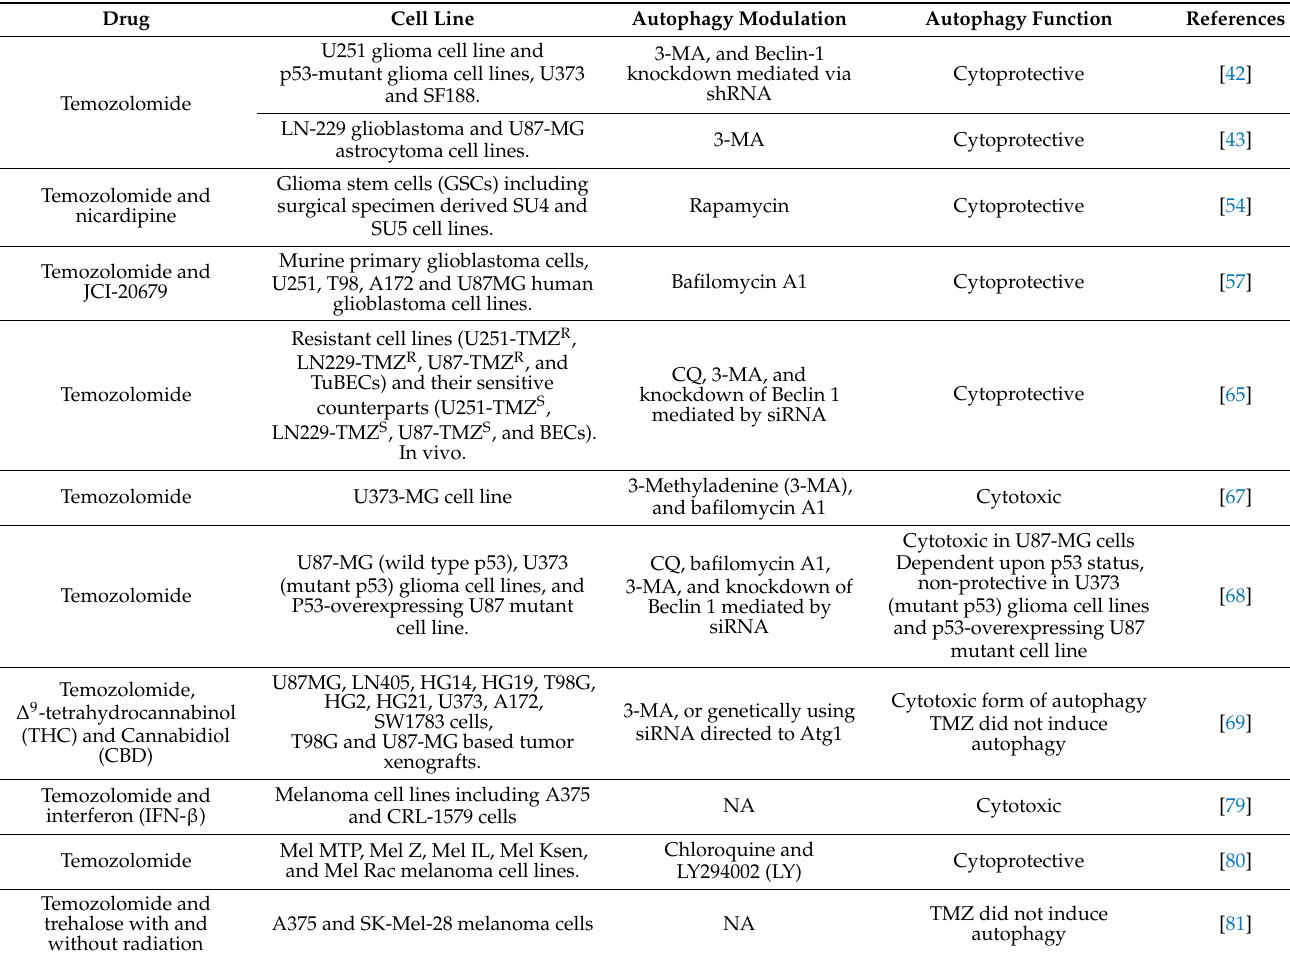
Table 2. The roles of autophagy mediated by temozolomide in different cancer